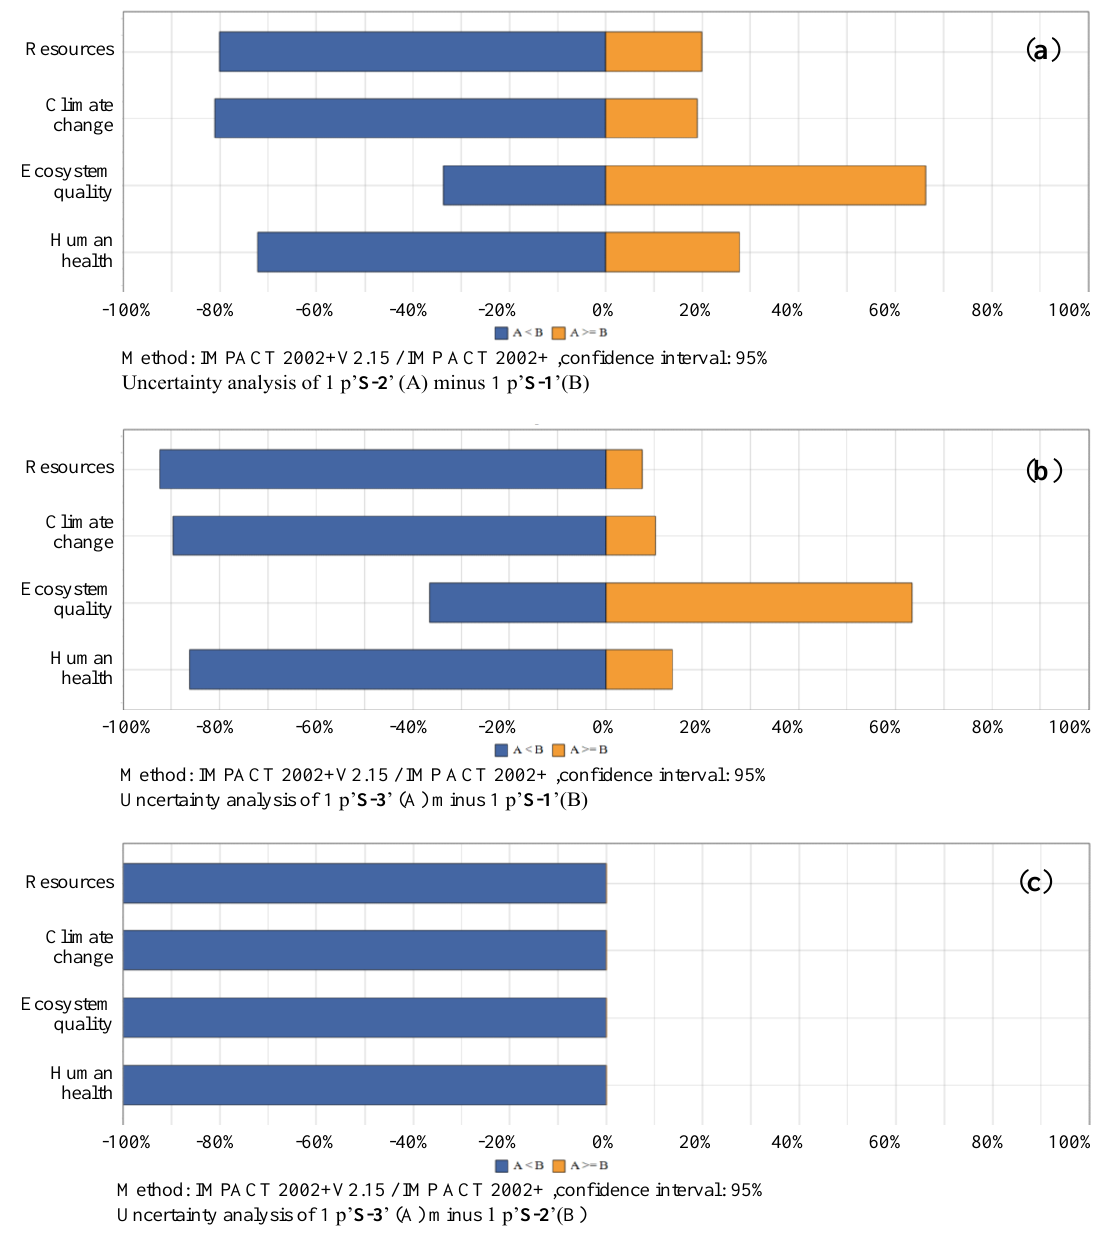
Figure 10. Probability distributions of damages, i.e., endpoint life cycle impact comparisons in between scenarios. ( a ) comparison between S−1 vs. S−2, ( b ) comparison between S−1 vs. S−3, ( c ) comparison between S−2 vs. S−3. Notes: with confidence interval of 95%, simulated by Monte Carlo sampling, 10,000 runs; IMPACT, Impact Assessment of Chemical Toxics; S, scenario.